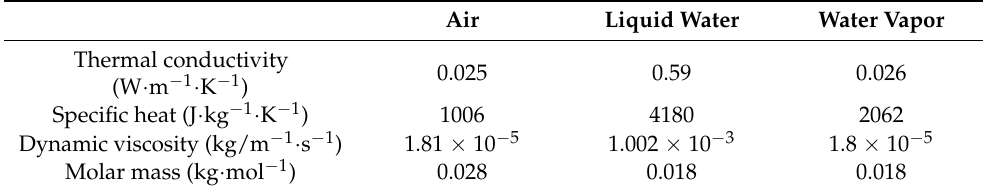
Table 2. Properties of the phases of the porous moist layers. Air Liquid Water Water Vapor Thermal